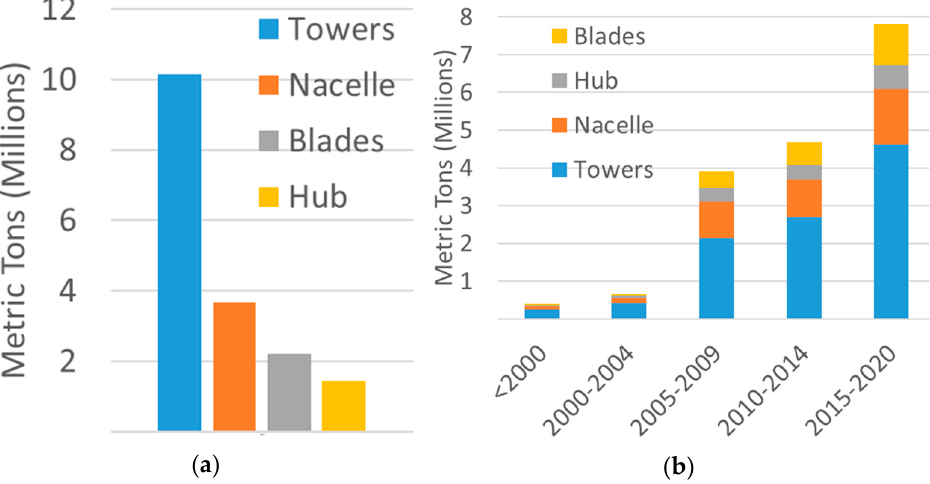
Figure 5. US—GoWInD over time ( a ) per component, ( b ) per time period, considering installation year from before the year 2000 to 2020.